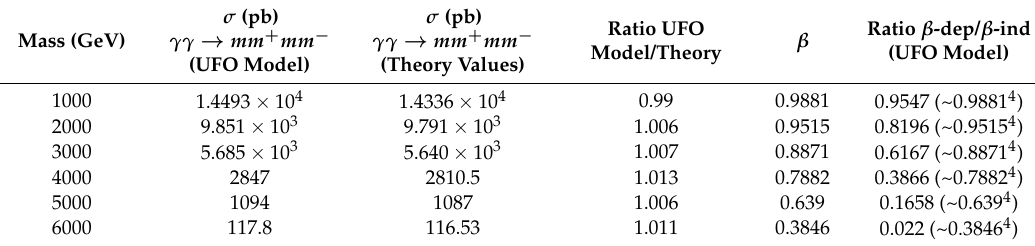
Table 2. The cross-section for the spin 0 monopole as obtained by the theory and the M AD G RAPH UFO model for the β -dependent coupling constant, when no PDF is used and the center-of-mass energy is 13 TeV. The fourth column shows the ratio of the cross-sections of the UFO model to that of the theoretical prediction. These ratios are very close to 1, suggesting excellent agreement between the theory and the M AD G RAPH model. Here, the sixth column shows the ratio of cross-sections as obtained by the UFO model for β -dependent coupling to β -independent coupling (shown in Table 1). This ratio varies as β 4 , as expected from the theory [10].